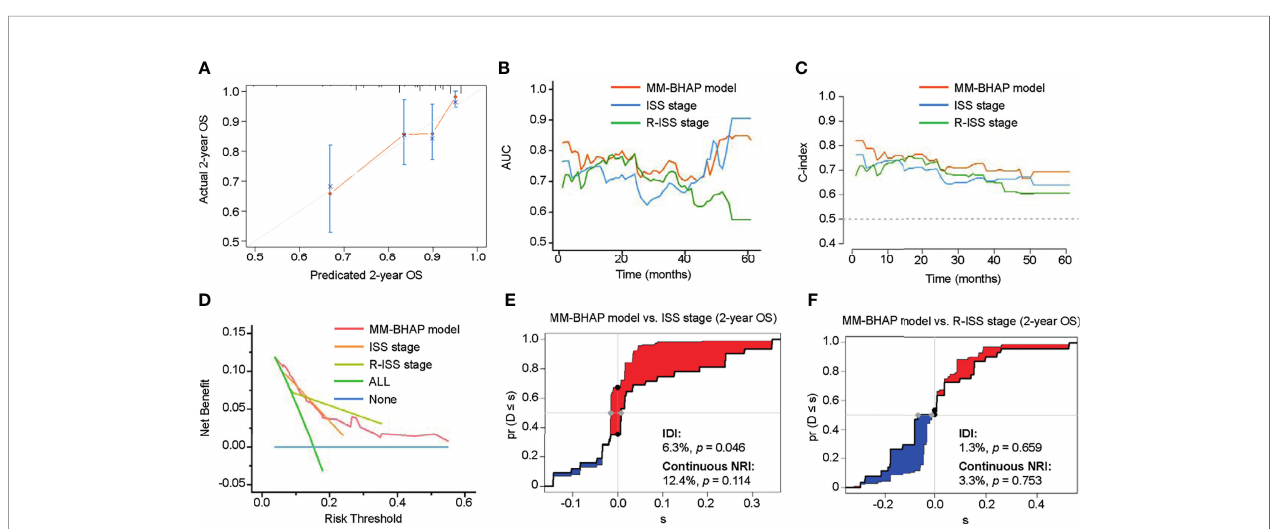
FIGURE 2 | The performance of the MM-BHAP model, ISS stage, and R-ISS stage for predicting OS in the development cohort. (A) The calibration curve of the MM-BHAP model for predicting 2-year OS. (B) The time-dependent AUC of the ROC in the three models. (C) The time-dependent Harrell ’ s C-index in the three models. (D) The DCA was used to estimate clinical usefulness of the three models for predicting 2-year OS. The improvement in prediction of the MM-BHAP model was compared to the ISS stage (E) or R-ISS stage (F) . The IDI was the value of the difference in area between red and blue zones (E, F) . The continuous NRI was the value of the distance between two black dots (E, F)